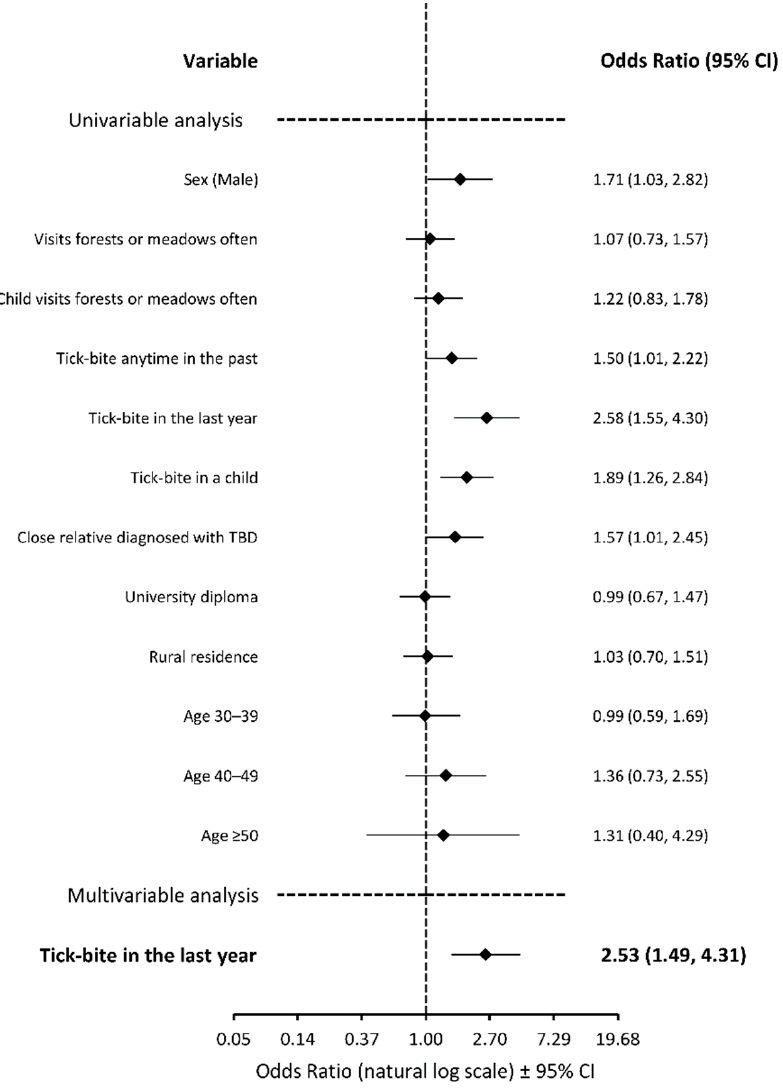
Figure 2. Binominal logistic regression analysis of variables associated with the odds of vaccinating or declaration to vaccinate the respondent’s child with the TBE vaccine. The age-related odds were calculated with reference to age under 30 years. Abbreviations: TBD, tick-borne disease.